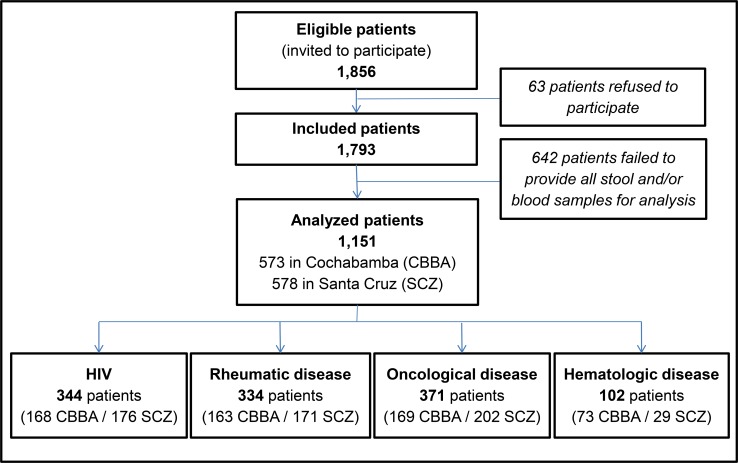
Study diagram with patient disposition.